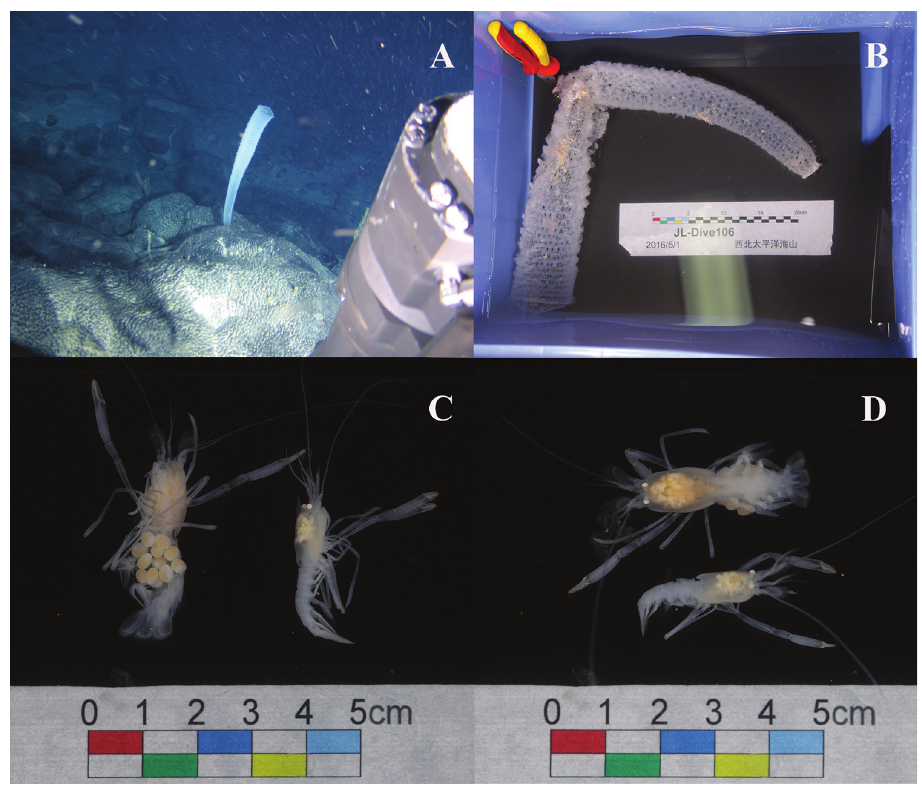
Figure 1. Hexactinellid sponge, Euplectella sp., in situ ( A ) and shortly after collection ( B ) C, D Spongi- coloides weijiaensis sp. n., ovigerous female and male shortly after extraction from the host sponge.